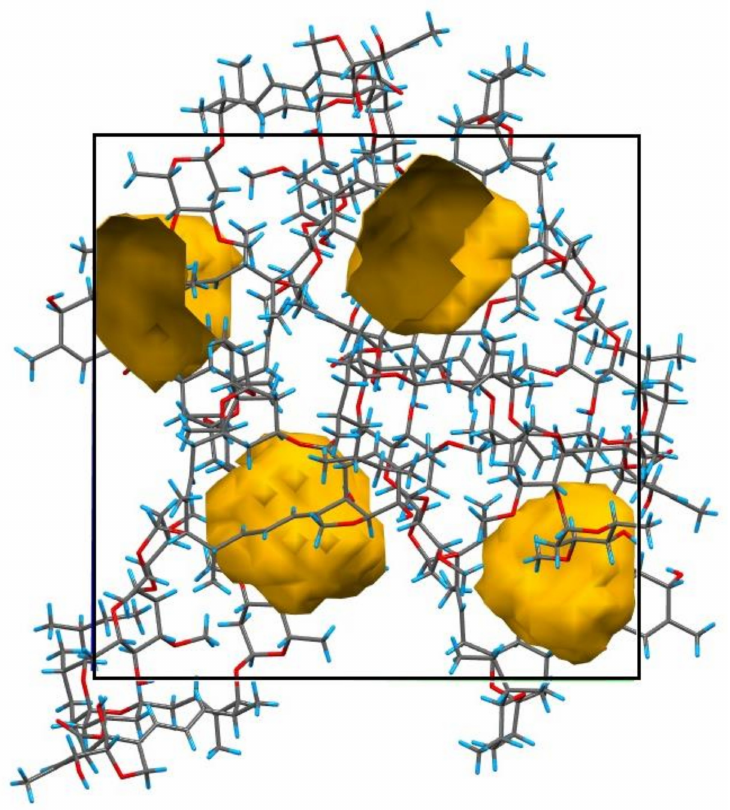
Figure 5. A projection of the unit cell of crystal II on the crystallographic plane (100) showing the voids.